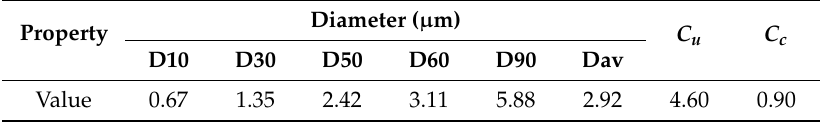
Table 2. Parameters of particle size